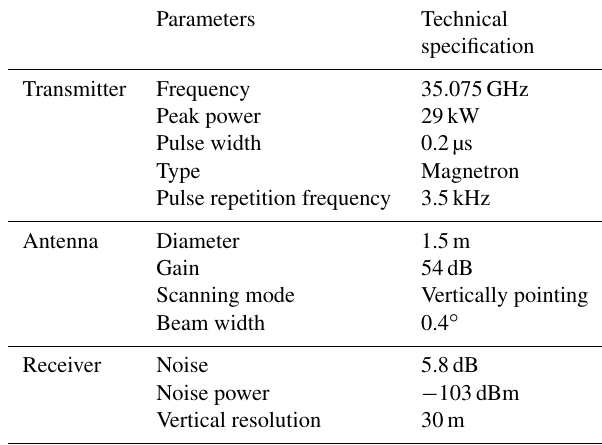
Table 1. Main technical specifications of the Ka radar at the